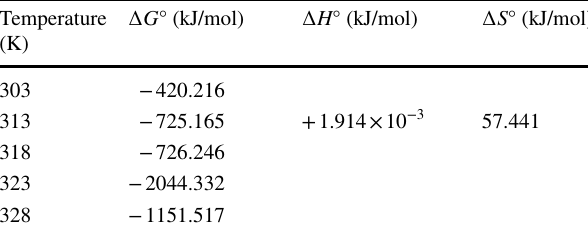
Table 3 Thermodynamics parameters for adsorption of Cr(VI)